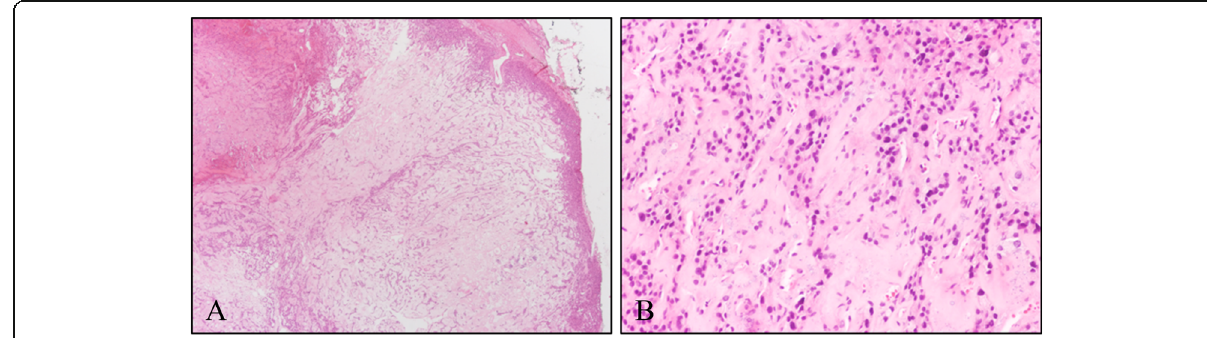
Fig. 2 Hematoxylin and eosin (H&E)-stained frozen section of the thyroid mass. a At low magnification (× 20), the tumor was relatively well- circumscribed. b At high magnification (× 200), the tumor cells were found to be arranged in a trabecular pattern between homogenous eosinophilic